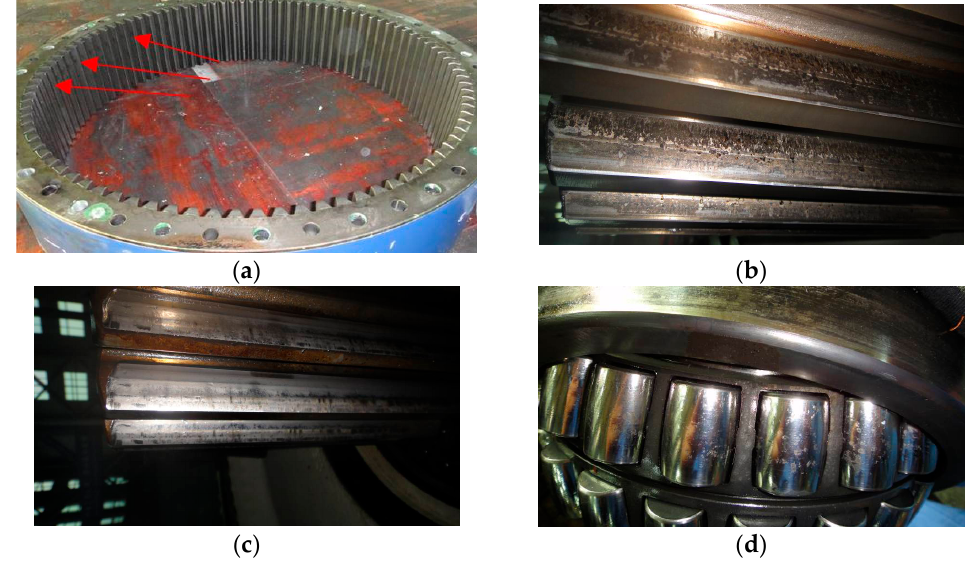
Figure 23. Distributed fault of planetary subassemblies in an 850 kW wind turbine gearbox: ( a ) ring gear; ( b ) pitting planet gear; ( c ) deformed sun gear; ( d ) pitting rolling elements of planet bearing.